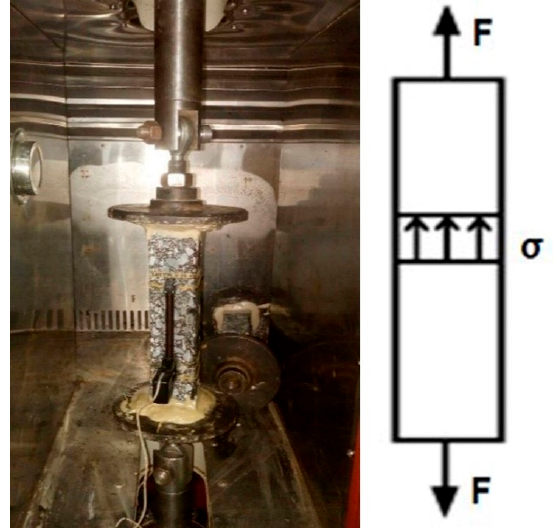
Figure 4. Direct tensile test and force diagram.